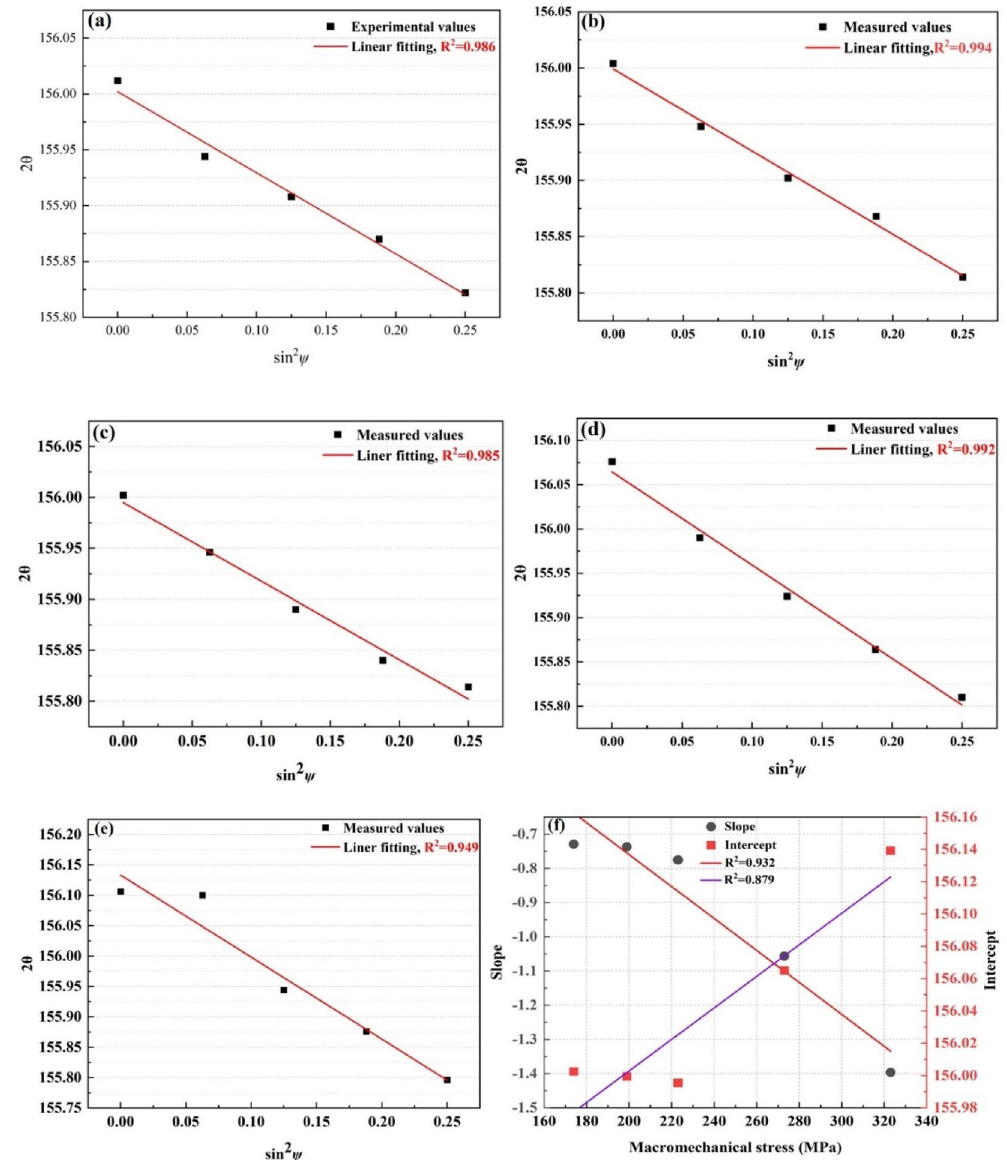
Figure 3. The results of experimental measurements for (211) diffraction plane of ferrite ( a – e ) the measurements of diffraction strain at 174 MPa,199 MPa, 223 MPa, 273 MPa, 323 MPa, respectively; ( f ) the diffraction data fitting of (211) diffraction planes of ferrite.